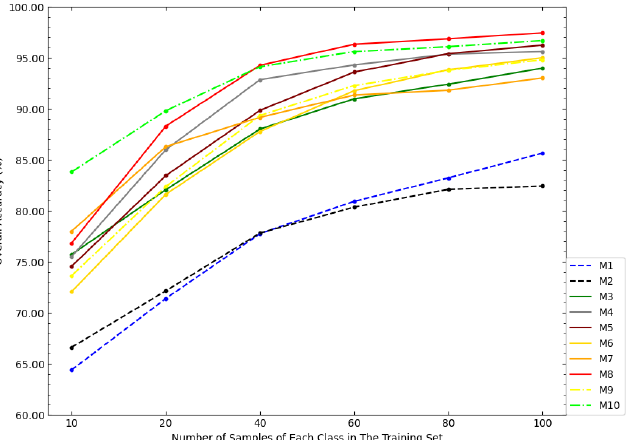
Figure 10. The OAs of each model in the PaviaU dataset under the partitioning of training sets of different sizes. Table 8. Running time (seconds) for the classification for Indian Pines, Salinas, PaviaU datasets by various models.